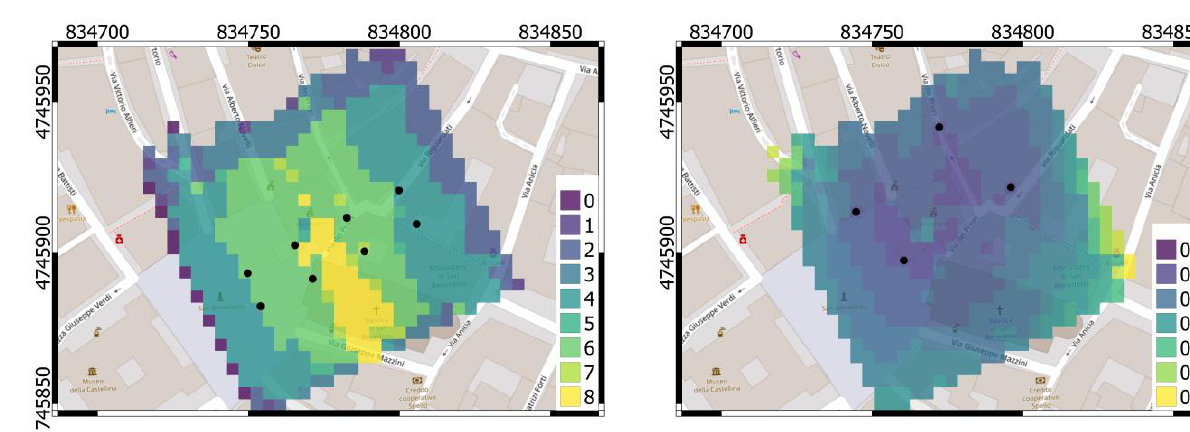
Figure 4. Occurrence map for the Civic Tower.